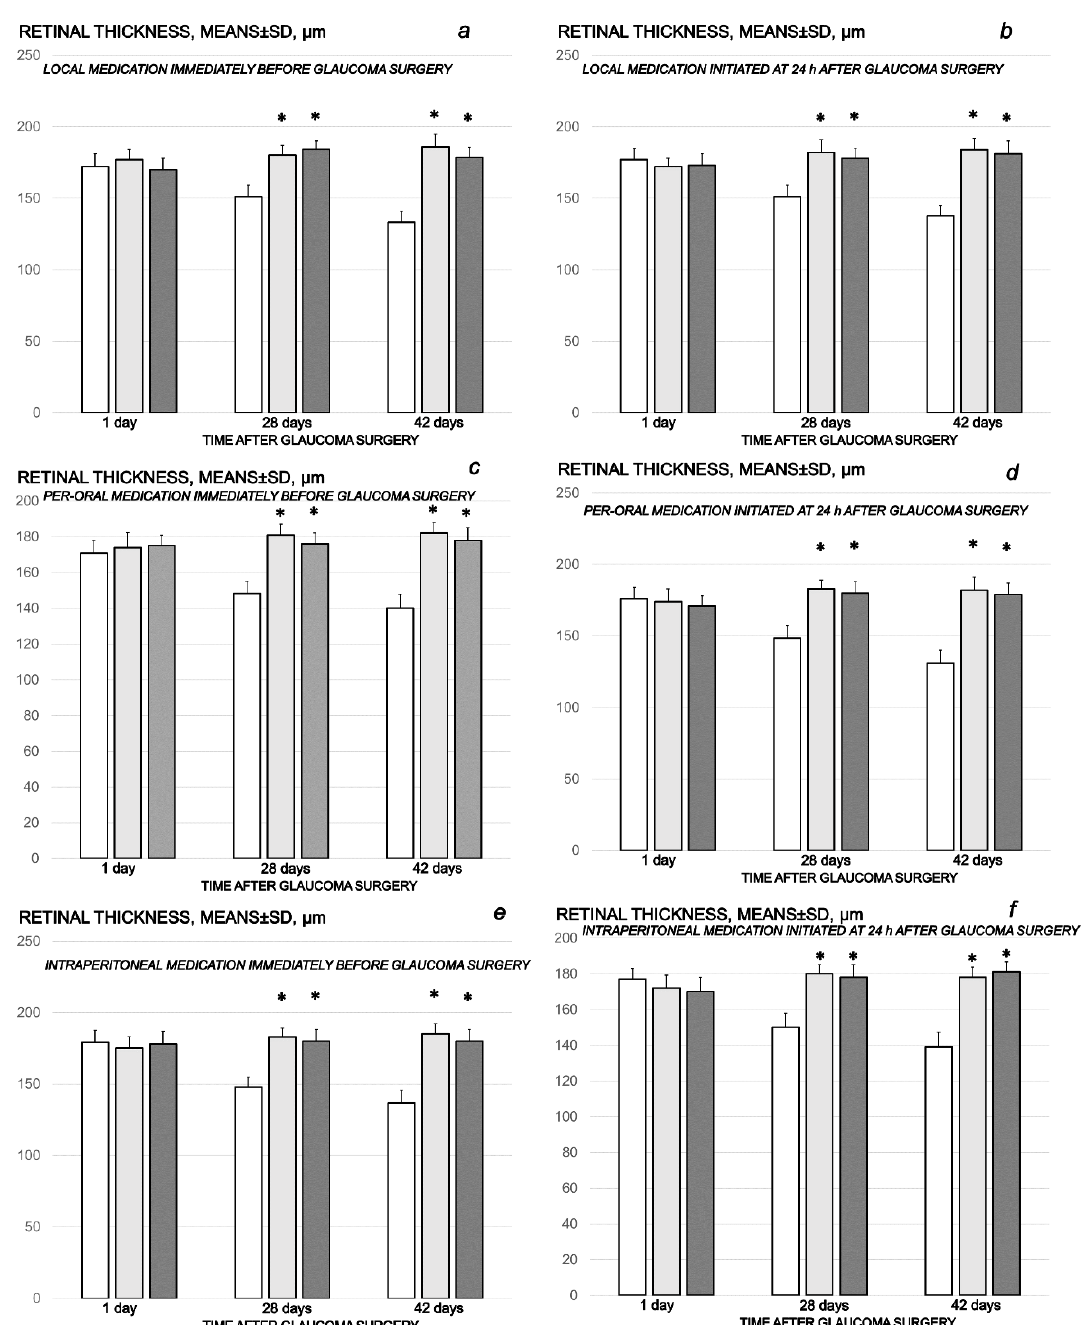
Figure 10. Cauterization of the three episcleral veins induced a decrease in retinal thickness, means ± SD, µ n, at the first post-operative day and at the end of the fourth and sixth post-injury week. Counteracting effect of BPC 157 medication daily regimen, prophylactic ( a – c ) or curative ( d – f ) (gray bars, light gray bars µ g-regimen, dark gray bars ng-regimen (0.4 µ g/eye, 0.4 ng/eye; 10 µ g/kg, 10 ng/kg) given locally as eye drops in each eye ( a , d ), intraperitoneally (last application at 24 h before sacrifice) ( b , e ) or per-orally in drinking water (0.16 µ g/mL, 0.16 ng/mL, 12 mL/rat until the sacrifice, first application given intragastrically) ( c , f )), started prophylactically (immediately before glaucoma surgery) or as curative treatment (at 24 h after glaucoma surgery). Controls (white bars) simultaneously received an equal volume of distilled water (two drops/eye), saline intraperitoneal application (5 mL/kg) or per-oral drinking water (12 mL/day/rat. A total of 6 rats/group/interval. * p < 0.05, at least, vs.